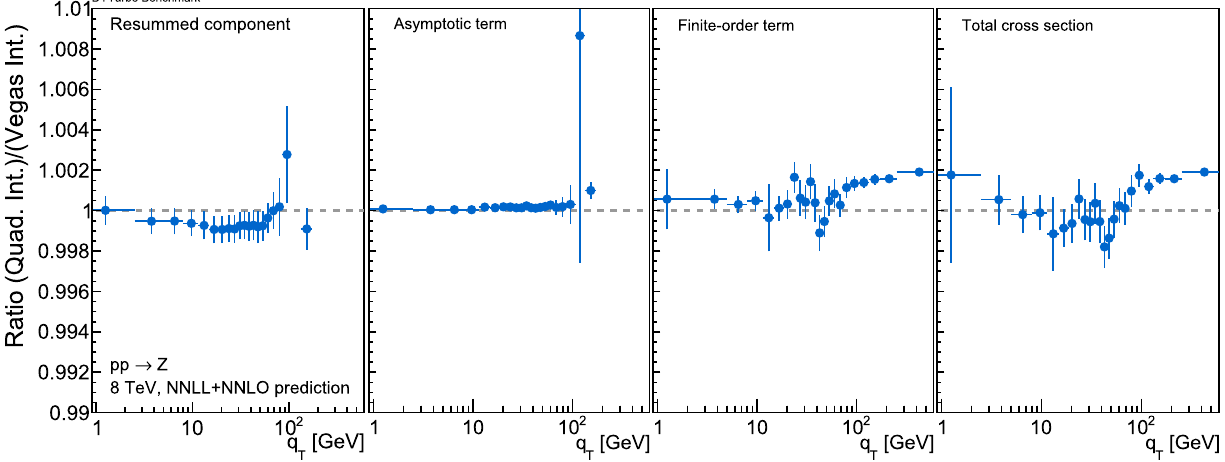
Fig. 5 Ratio of full-lepton phase space differential cross sections at √ s = 8 TeV as a function of Z -boson transverse momentum as evalu- ated with the Quadrature and Vegas integration methods of DYTurbo